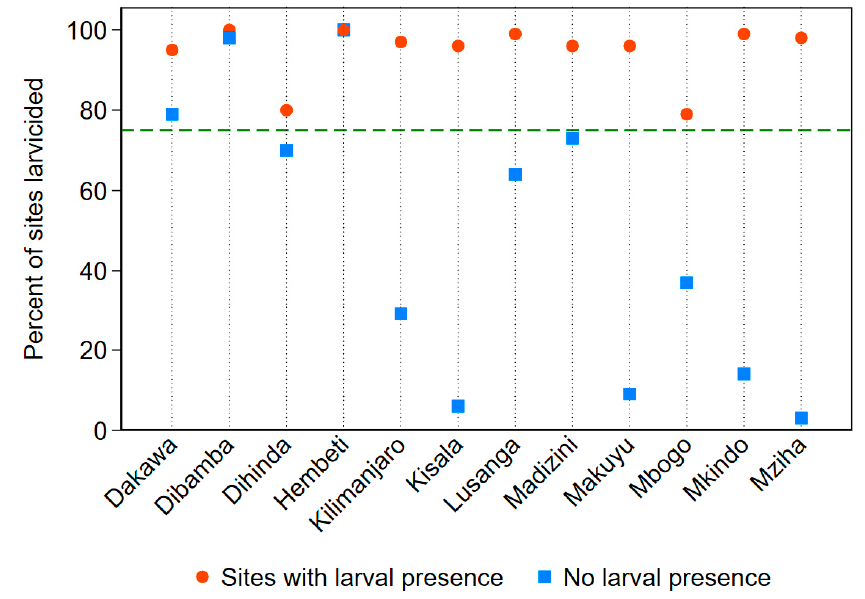
Figure 4. Percentage of sites visited receiving larvicide application of any amount for sites with and without reported larval presence. The green dashed line depicts the success standard of 75%.